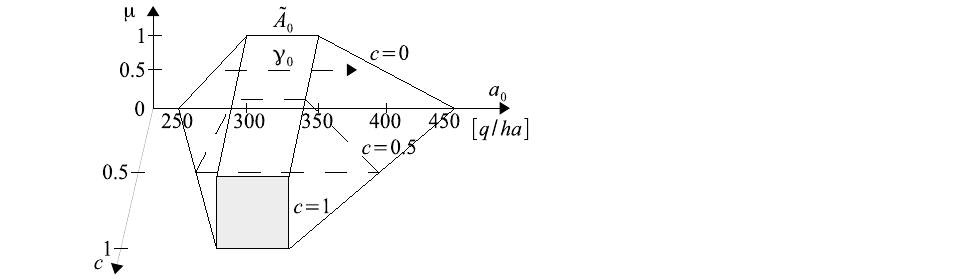
Figure 32. Knowledge about the value of the zero fertilization coefficient a 0 [ q/ha ] presented in the form of T2FN.